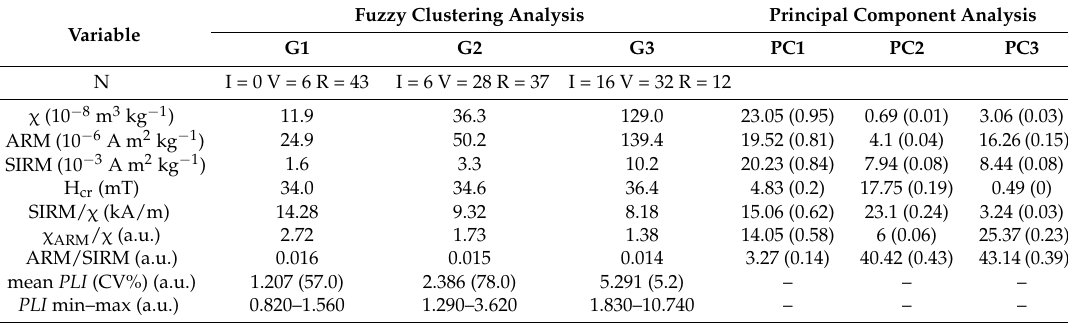
Table 3. Summary of multivariate analysis of T. recurvata samples. Clusters with similar magnetic features obtained from fuzzy clustering analysis; and loading values from principal component analysis, the values in brackets correspond to the correlation with the principal component. Fuzzy Clustering Analysis Principal Component Analysis Variable G1 G2 G3 PC1 PC2